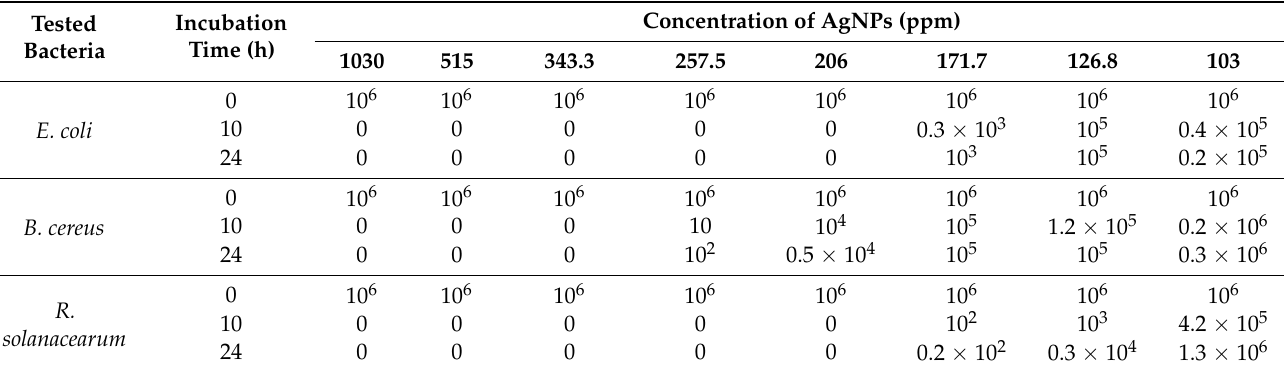
Table 3. The densities of liquid bacterial cultures (CFU/mL) after treatment with AgNP solution biosynthesized in process B under incubation with 1 mM AgNO 3 .